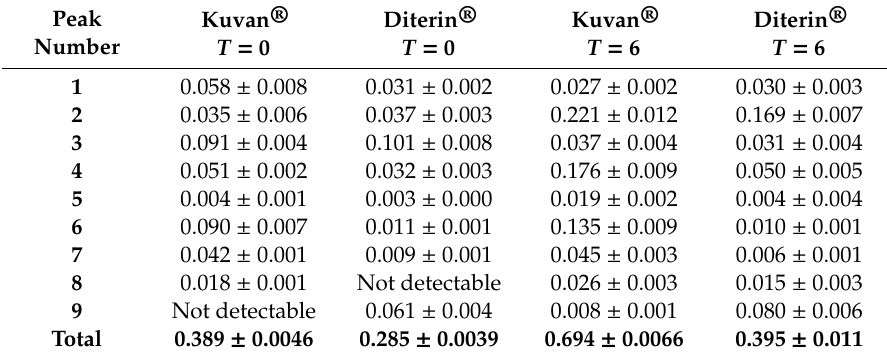
Table 2. Percentage concentration of the impurities for Kuvan ® and Diterin ® tablets at di ff erent times. Peak areas of ascorbic acid and sapropterin have been omitted. Data are presented as the mean ± SD of at least three independent measurements carried out for each